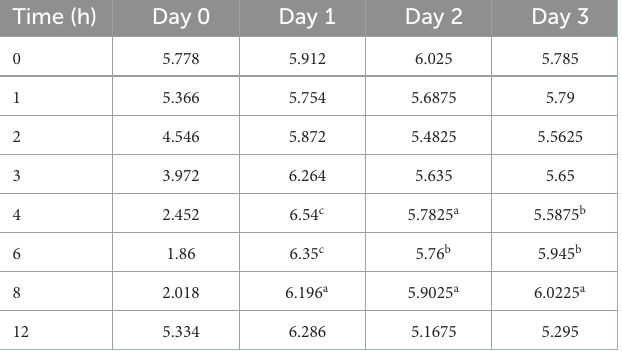
TABLE 5 Comparison of average hourly abomasal pH after intravenous administration of pantoprazole.